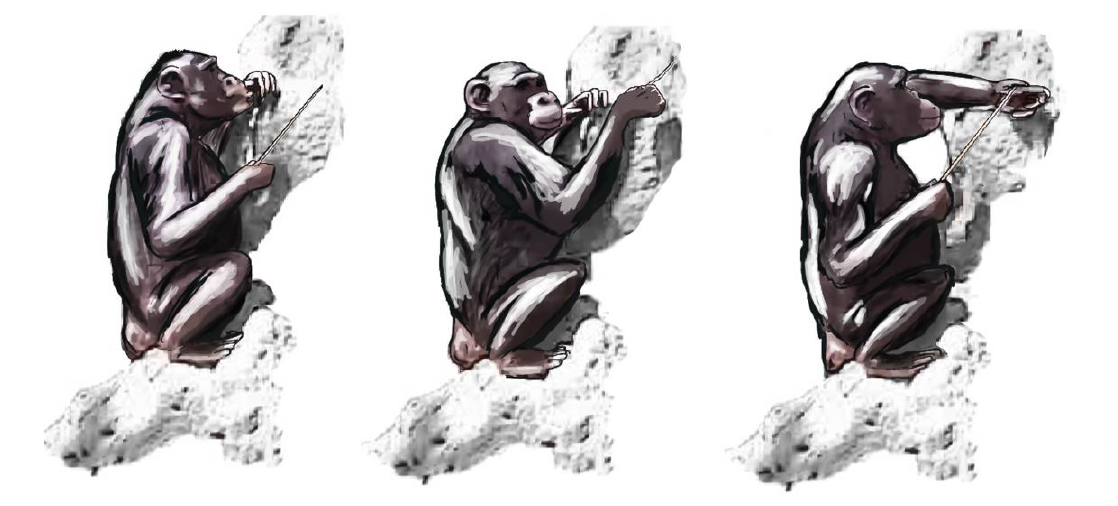
Illustration of a Chimpanzee Fishing for Termites with a Plant Stem